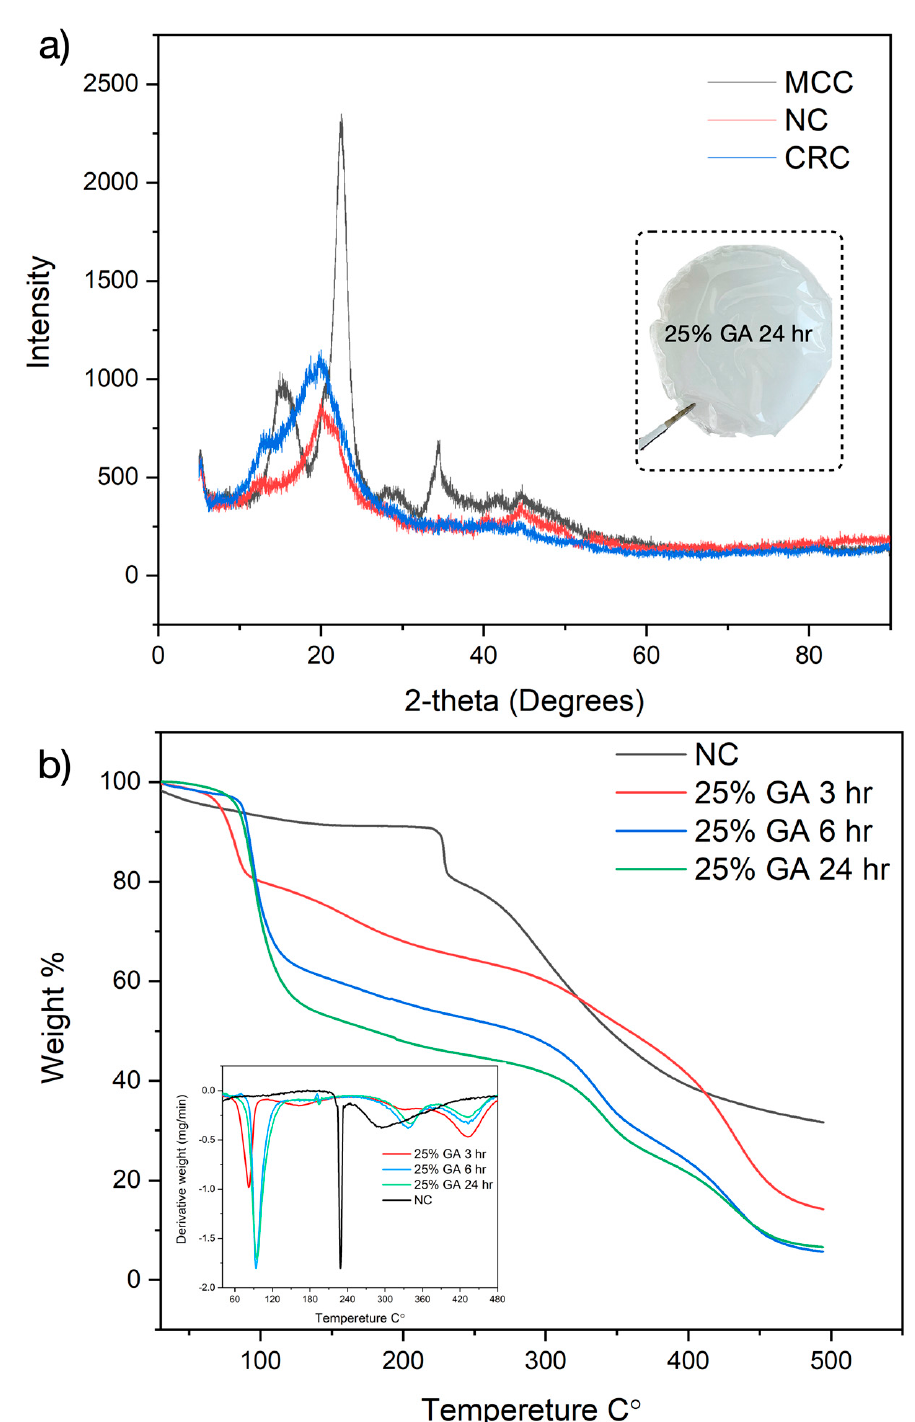
( a ) XRD analysis of MCC (mother material), freeze-dried NC, and freeze-dried CRC-25%-24 hr with inset digital image of 25% GA-crosslinked NC for 24 hr, ( b ) TGA and DTG curves of NC and CRC crosslinked for 3, 6, and 24 hr using 25% GA with inset representing the DTG